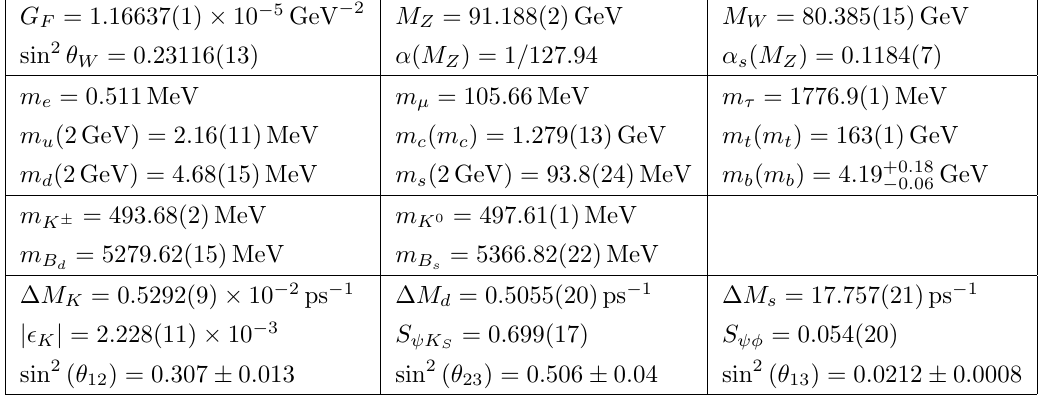
Table 1 . Values of theoretical quantities used for the numerical analysis.